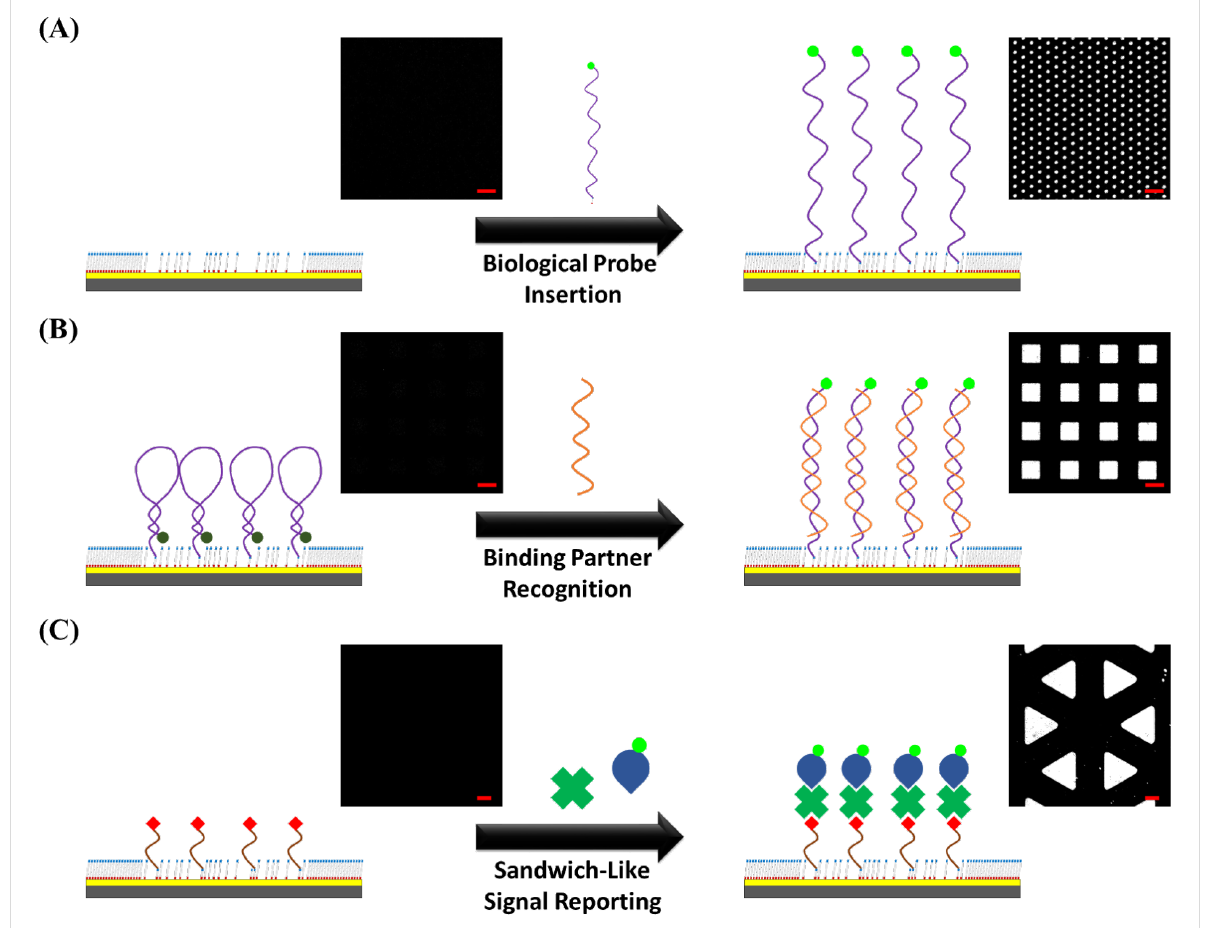
Figure 2: Different types of bioactive surfaces fabricated by the chemical lift-off lithograpy (CLL) process with corresponding fluorescence images. (A) Direct signal reporter-labelled probe insertion: the CLL-treated substrate before (left) and after (right) FAM-labelled Hg 2+ -specific probe insertion. (B) Binding partner recognition triggered probe structure change inducing signal readout: the CLL-treated substrate anchoring with the FAM-labelled hairpin-structured DNA probe before (left) and after (right) target DNA introduction. (C) Sandwich-like signal reporting with the inserted probe: the CLL-treated substrate anchoring with the biotinylated thiol before (left) and after (right) the conjugation with streptavidin and FITC-labelled antistrepta- vidin antibody. The scale bars are 20 μ